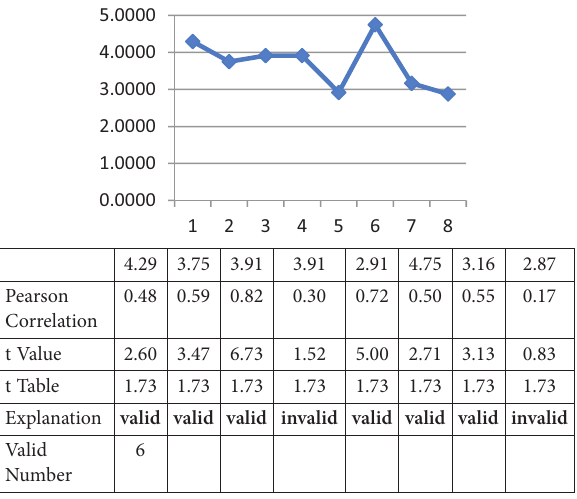
Table 4. Degree of residents’ satisfaction with the layout and environment of the housing